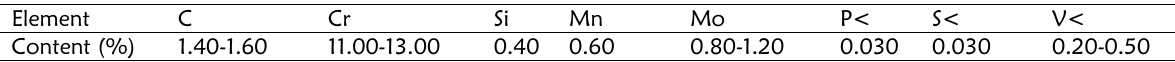
Table 1: Chemical composition of AISI